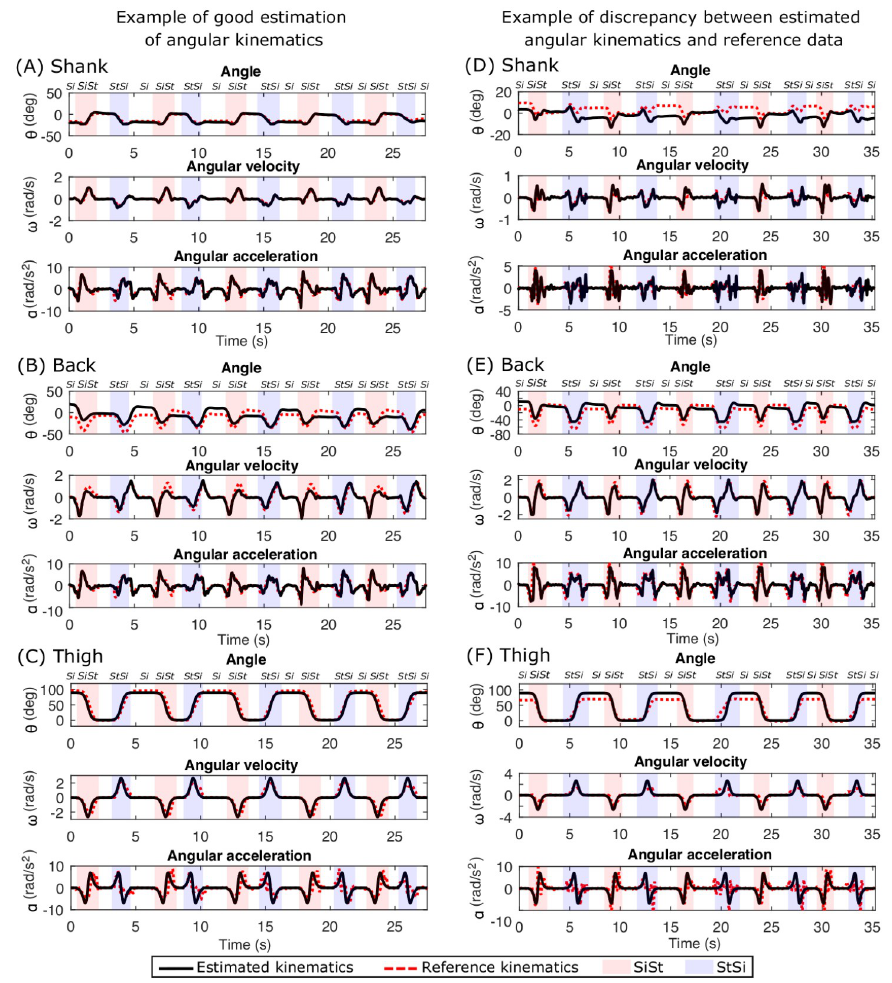
Fig 6. Comparison of estimated kinematics with Codamotion reference kinematics in young healthy participants. An example of good angular kinematics estimation (left column) is shown for (A) Shank, (B) Back and (C) Thigh. The segmentation of sit-to-stand, stand-to-sit, sit and stand (no label on the top) is also shown with different background colours and labels at the top. An example of discrepancies between estimated kinematics and reference kinematics from Codamotion data (right column) is shown for (D) Shank, (E) Back and (F)